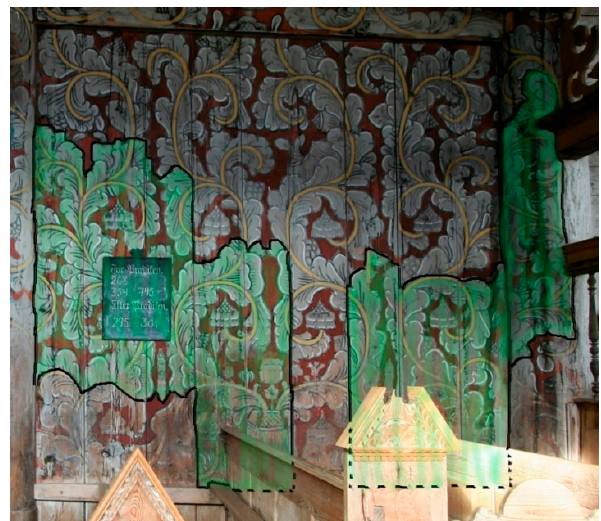
Figure 5. Example of mapping of conservation treatment in Kvernes stave church. The image shows the eastern part of the north wall in the nave of Kvernes stave church. Areas marked with green were consolidated with sturgeon glue (date: 5 April 2013). Photo © NIKU 2013.